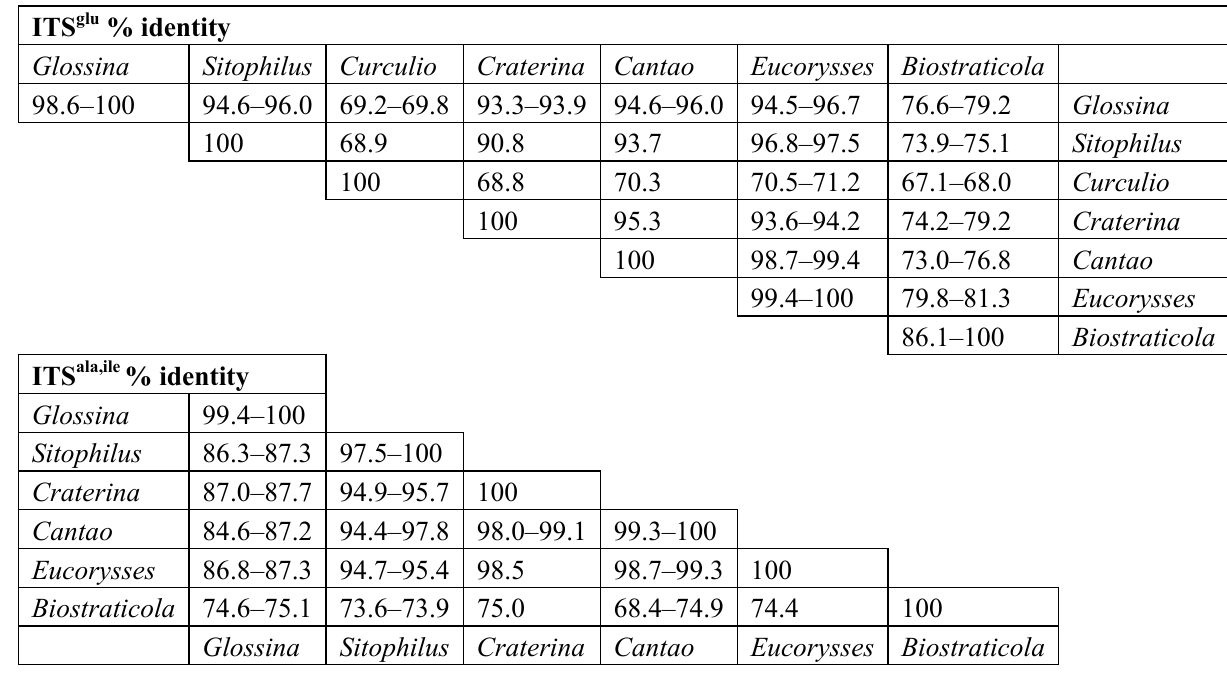
Table 2. Percent nucleotide identity of ITS regions among Sodalis and allied symbionts. Host genera are specified, with the exception of the free-living Biostraticola